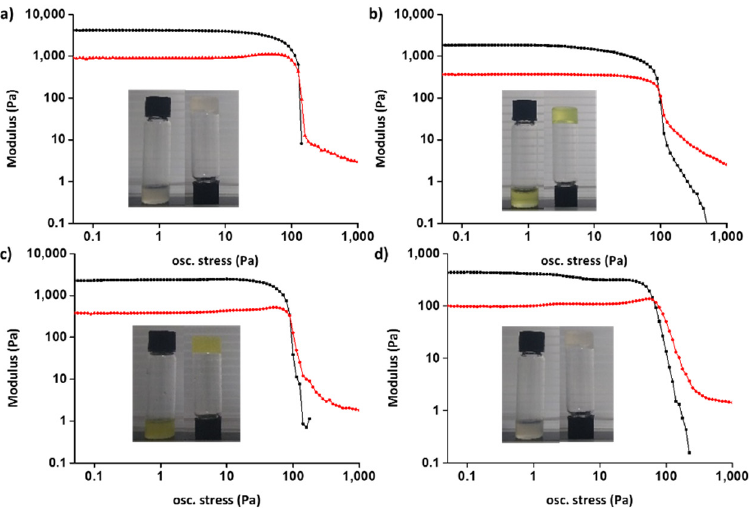
Figure 1. Stress sweep rheometry (storage/elastic moduli G ′ in black and viscous moduli G ′′ in red) and inversion tube test images: ( a ) L2 in nitrobenzene (1.0% w / v ); ( b ) L2 in chlorobenzene (0.75% w / v ); ( c ) L3 in nitrobenzene (0.75% w / v ); ( d ) L3 in chlorobenzene (0.75% w / v ). Oscillatory amplitude sweeps at a constant frequency (1 Hz).